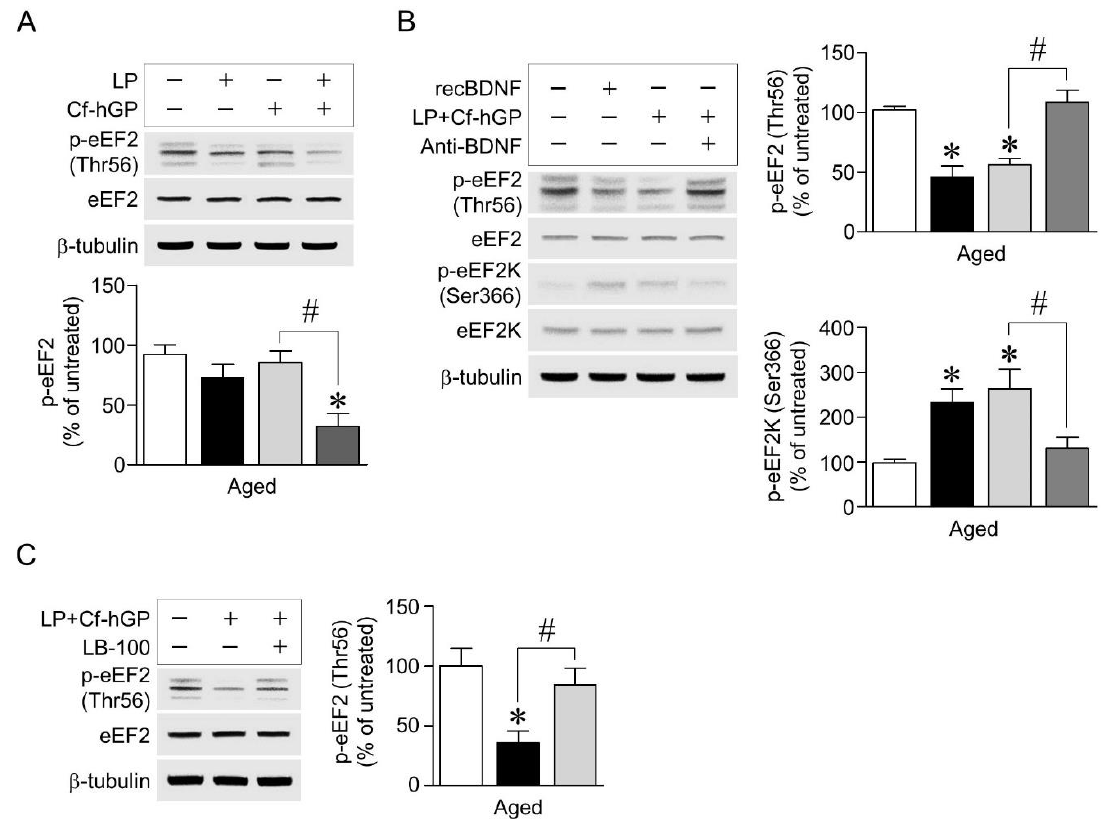
Figure 4. Regulation of BDNF-mediated phosphorylation of eukaryotic elongation factor 2 (eEF2) by co-treatment with Cf-hGP and L. plantarum . Phosphorylation of eEF2 at threonine 56 was decreased by co-treatment with Cf-hGP and L. plantarum , but not by any mono-treatment ( A ). Phosphorylation of the eEF2 kinase was upregulated, while eEF2 phosphorylation was downregulated by the co-treatment, which was overturned by functional blocks with the anti-BDNF antibody (1 µ g / µ L) ( B ). The co-treatment-induced decrease in eEF2 phosphorylation was downregulated by inhibition of protein phosphatase 2A (PP2A) with LB-100 (an inhibitor of PP2A, 1.5 mg / kg) ( C ). * p < 0.05 versus untreated rats; # p < 0.05 versus the rats co-treated with Cf-hGP and LP. Cf-hGP, Capsosiphon fulvescens glycoprotein; LP, Lactobacillus plantarum ; eEF2K, eEF2 kinase; p-eEF2K, phosphorylated eEF2K; Thr56, threonine 56; Ser366, serine